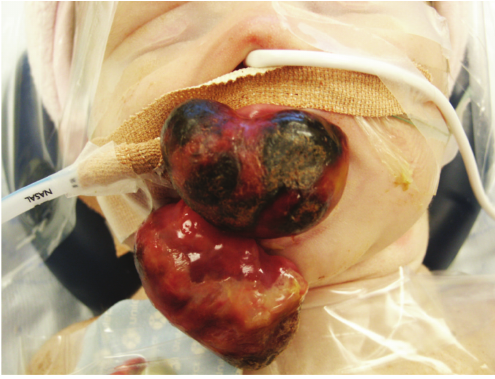
Figure 3: Hematoxylin and eosin stain × 100 showing overlying stratified sqamous epithelium and vascular stroma.